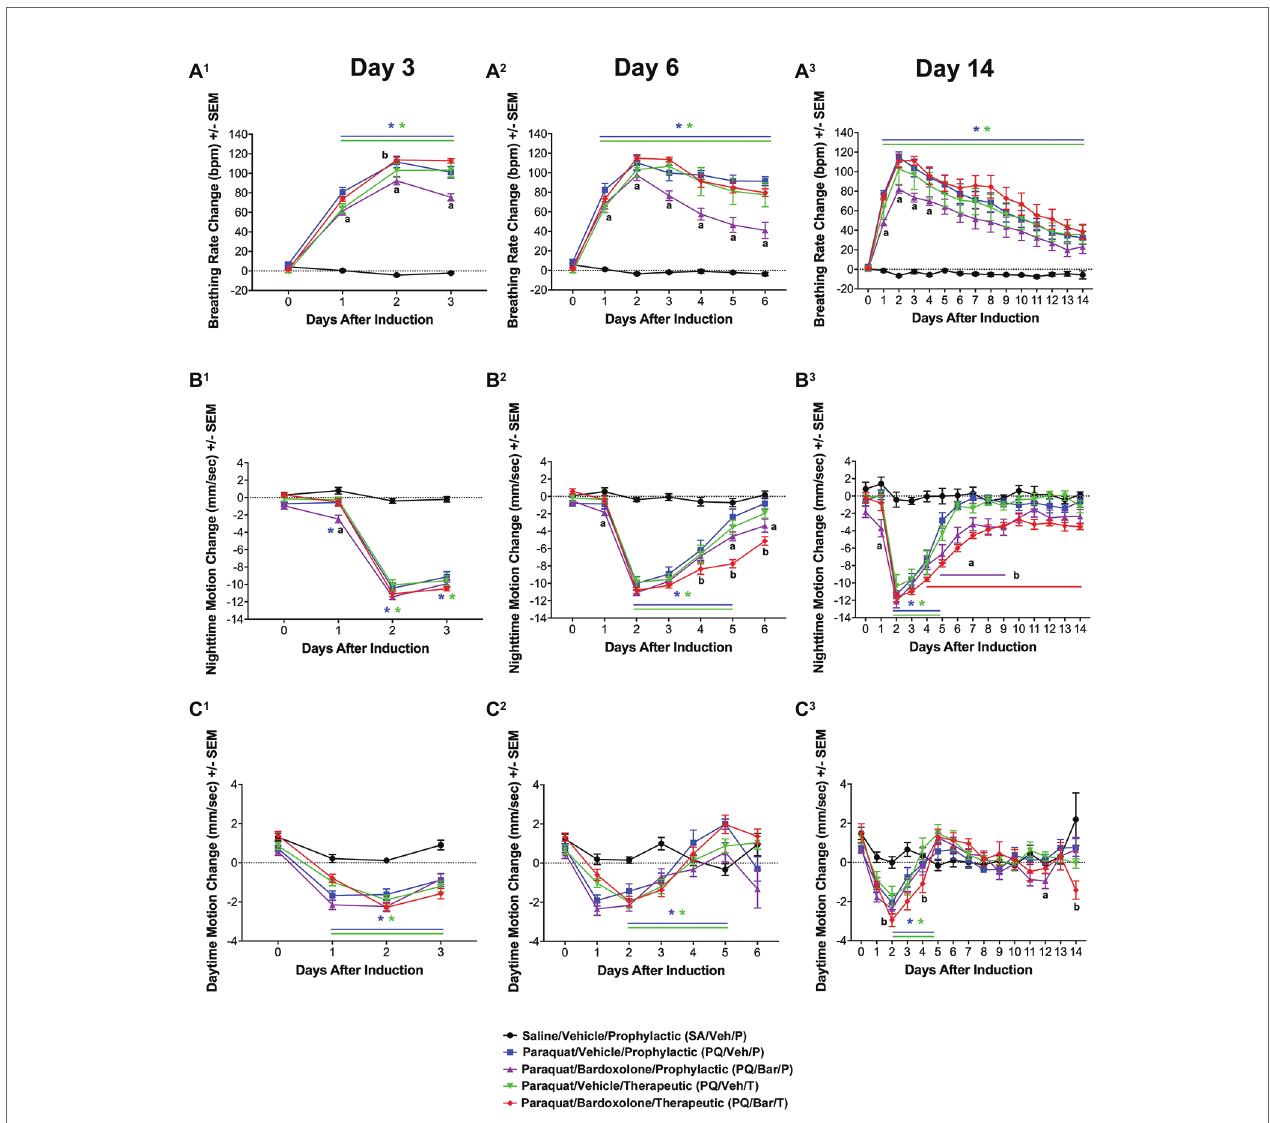
FIGURE 2 | Automated breathing rate and body motion detected injury and effects of bardoxolone in a rodent model of PQiLI. (A) Change in breathing rate. Compared with control rats (SA/Veh/P), breathing rate was increased in PQ/Veh/P and PQ/Veh/T rats. Elevated breathing rate was observed as early as Day 1 and as late as Day 14. PQ/Bar/P, but not PQ/Bar/T, rats had lower breathing rates compared with vehicle-treated counterparts. * p ≤ 0.01 vs. SA/Veh/P, a p ≤ 0.05 PQ/Veh/P vs. PQ/Bar/P, and b p ≤ 0.05 PQ/Veh/T vs. PQ/Bar/T. (B) Change in nighttime body motion. Compared with SA/Veh/P rats, nighttime body motion was decreased in PQ/Veh/P and PQ/Veh/T rats as early as Day 1 and as late as Day 5. The recovery of nighttime body motion in PQ/Bar/P and PQ/Bar/T rats was delayed. * p ≤ 0.01 vs. SA/Veh/P. a p ≤ 0.05 PQ/Veh/P vs. PQ/Bar/P and b p ≤ 0.01 PQ/Veh/T vs. PQ/Bar/T. (C) Change in daytime body motion. Compared with SA/Veh/P rats, daytime body motion was decreased in PQ/Veh/P and PQ/Veh/T rats as early as Day 1 and as late as Day 12. PQ/Bar/P and PQ/Bar/T rats showed lower daytime body motion compared with vehicle-treated counterparts during specific days. (A 1 ,B 1 ,C 1 ) Day 3 ( n = 24 rats for all study groups except n = 23 for SA/Veh/P). (A 2 ,B 2 ,C 2 ) Day 6 ( n = 16 rats for all study groups). (A 3 ,B 3 ,C 3 ) Day 14 ( n = 8 rats for all study groups except n = 7 for SA/Veh/P). * p ≤ 0.05 vs.